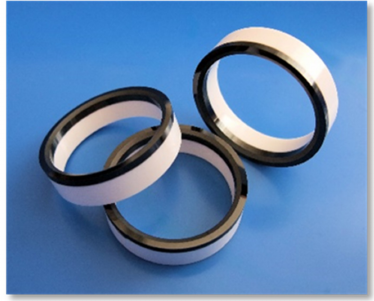
Figure 2. Two-colored zirconia components manufactured by 2C-CIM (manufactured by group “Shaping”,